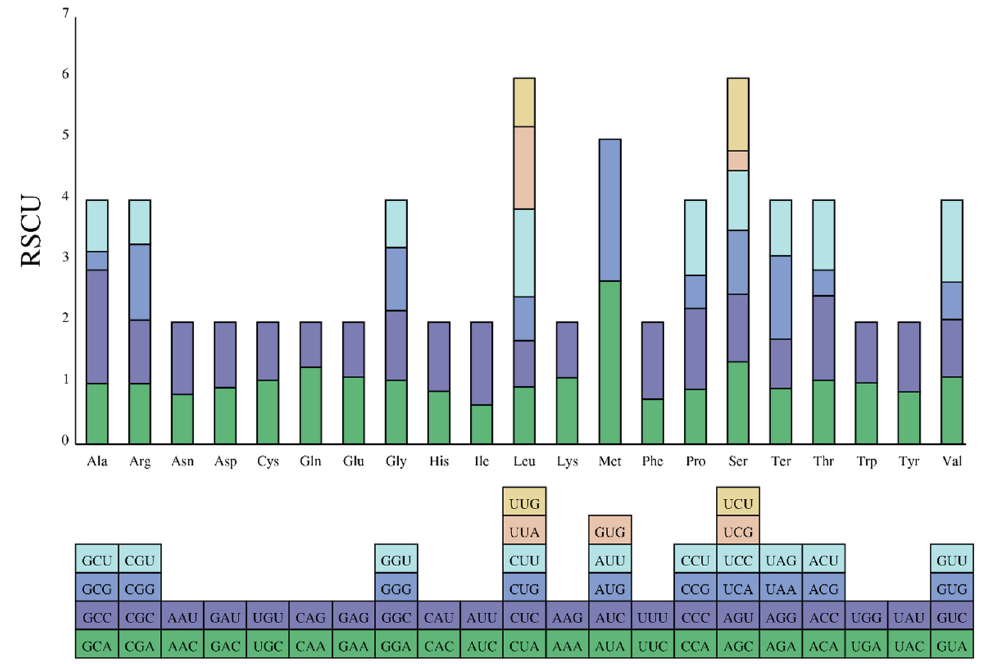
Figure 3. The codon content bar plot of the amino acids of 13 PCGs in the T. bombifrons mitogenome.